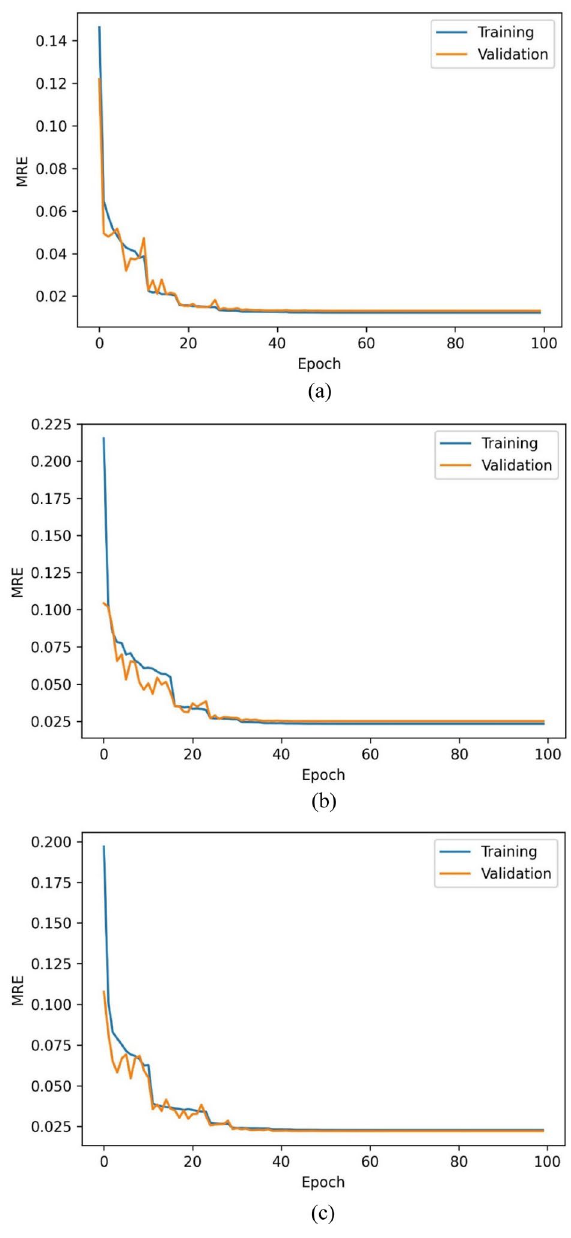
Figure 12. Training MRE of ( a ) R 04 , ( b ) R 05, and ( c ) R 06 models.